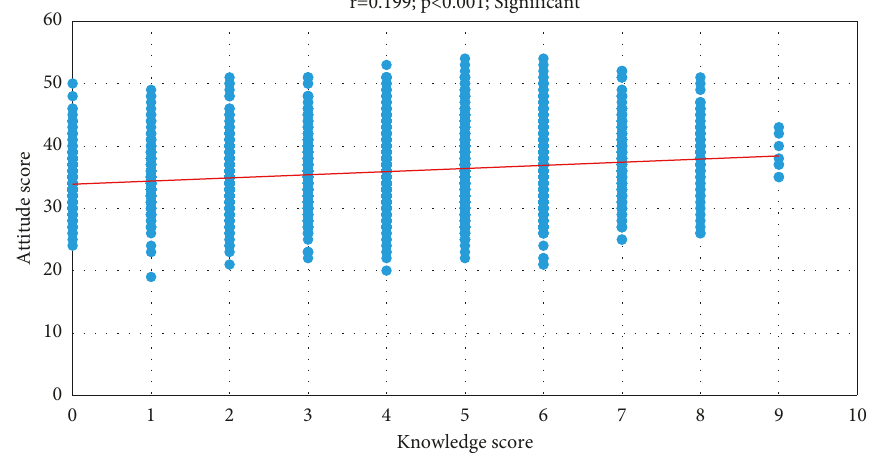
Figure 3: Correlation (Pearson r) between the knowledge score and attitude score. Table 3: Differences in knowledge and attitude scores based on participant socio-demographic characteristics ( n � 3764)